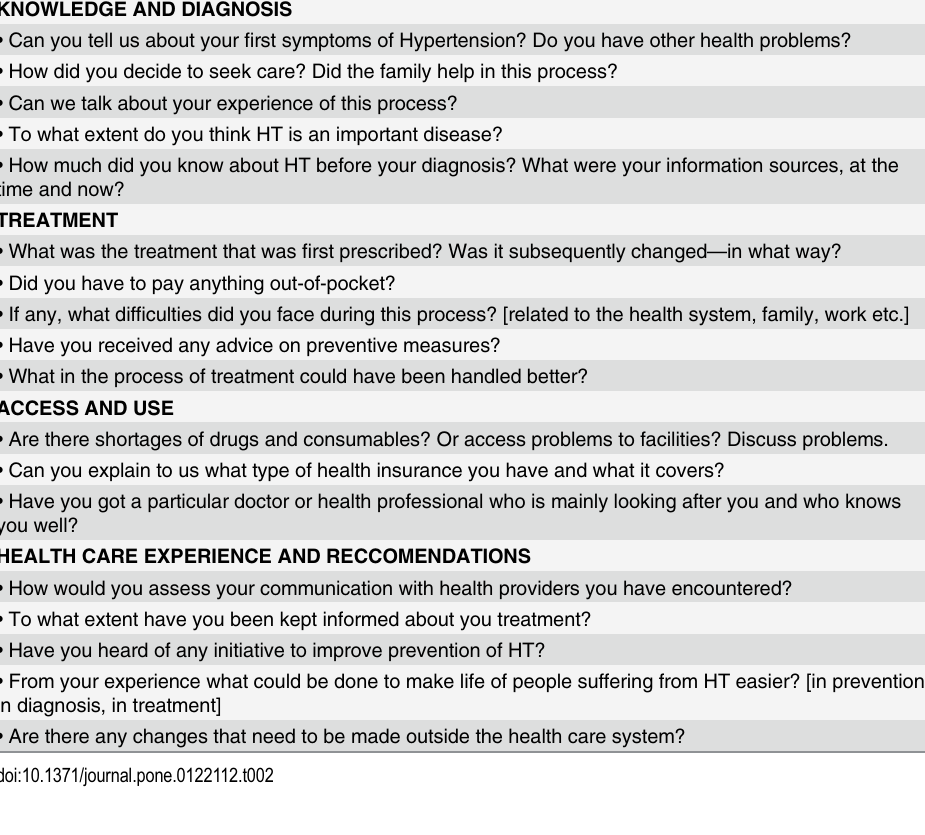
Table 2. Summary Interview Guide.